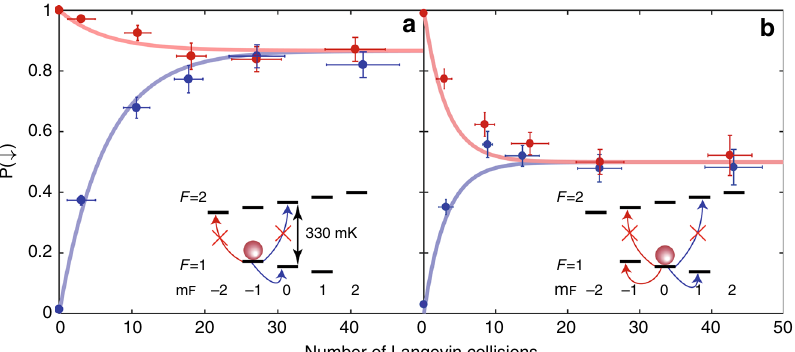
state, P( ↓ ), as function of number of Langevin collisions (time). In blue Sr þ ( a ) or 1 ; 0 j i ( b ). Insets show energetically allowed and Rb Rb